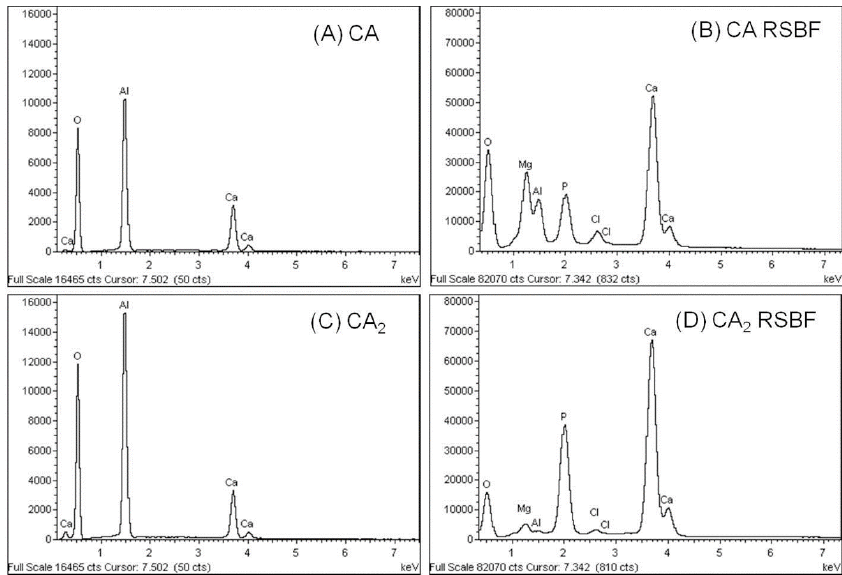
Figure 2. EDX spectra of the surface of the phases before immersion in SBF: (A) CA, (C) CA RSBF, (D) CA